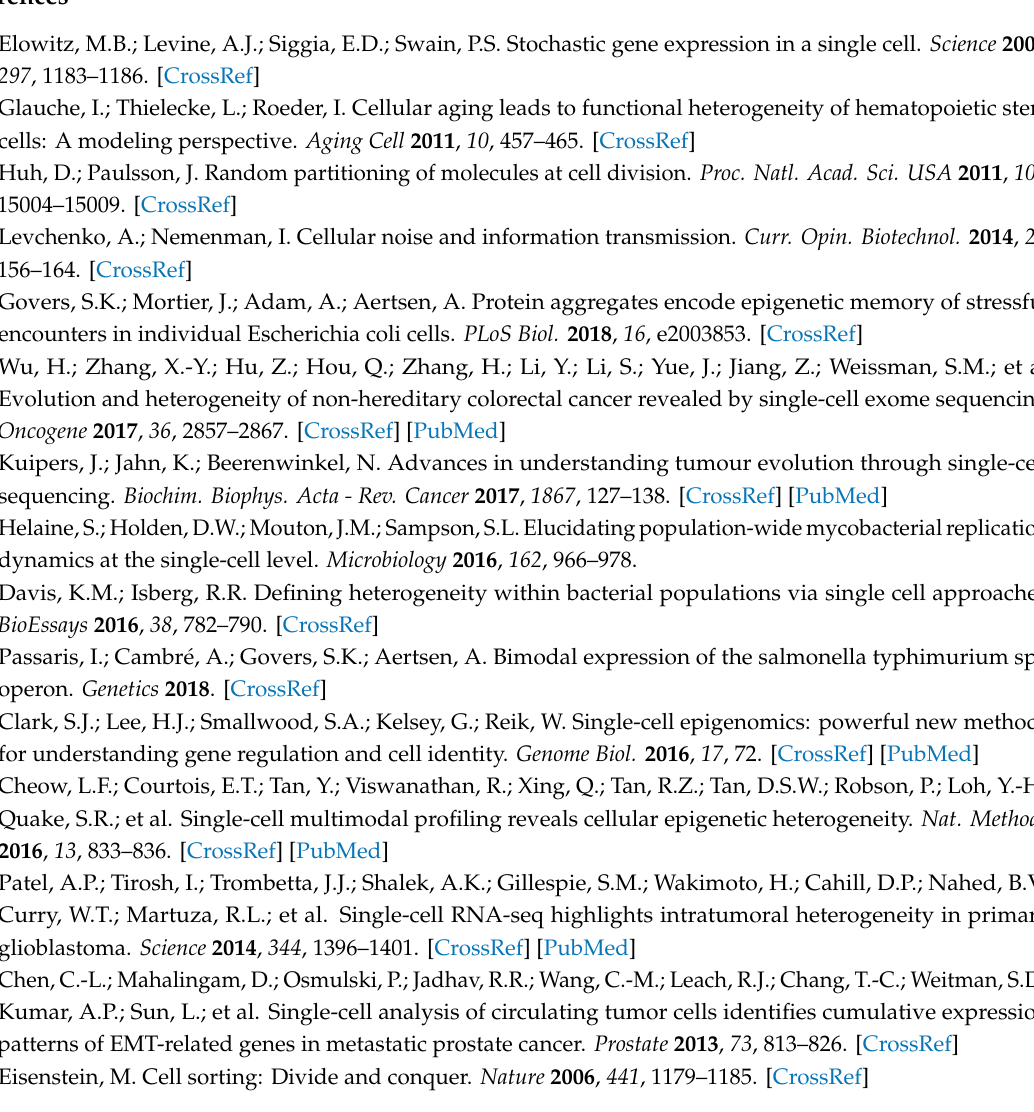
Section S1: Fabrication of DMF platform, Table S1: Bu ff er composition, Figure S1: Goodness of fit plot, Figure S2: Capture of Salmonella on MBs, Video S1: Optical tweezing of